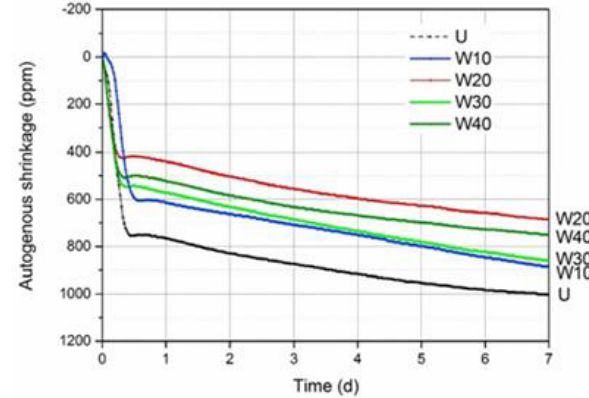
Figure 16: Autogenous shrinkage of concrete pastes with different content of tailings content